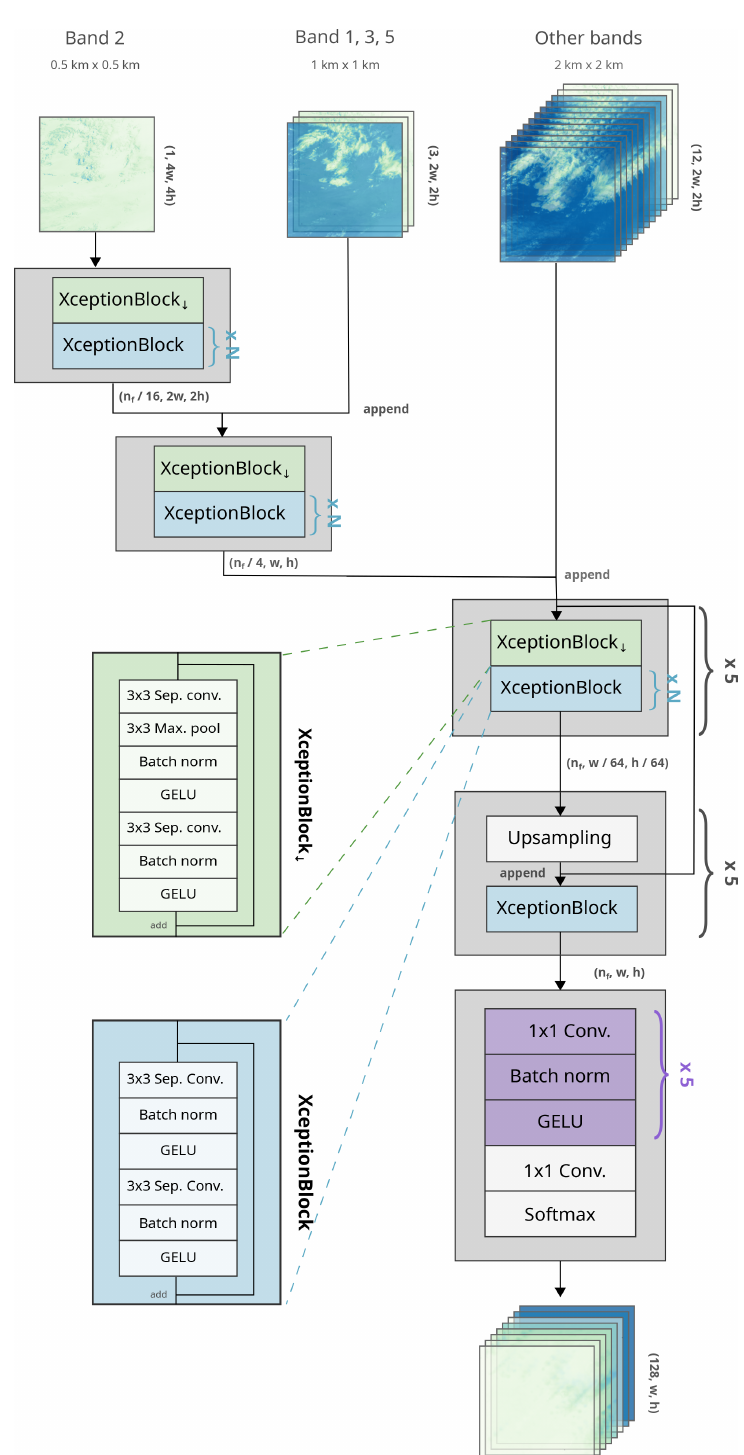
Figure 4. The neural network architecture used by the Hydronn 2 , All retrieval. For the Hydronn 4 , IR and Hydronn 4 , All retrievals, the two addi- tional stages for the processing of the higher-resolution inputs are omitted. Instead, the input comprises all input observations downsampled to 4km resolution. Grey text in parentheses gives the shape of the tensors at the various stages of the network using channel-first ordering and omitting the batch dimension. Bold grey text specifies merge operations for data streams. Braces are used to mark the repetition of network